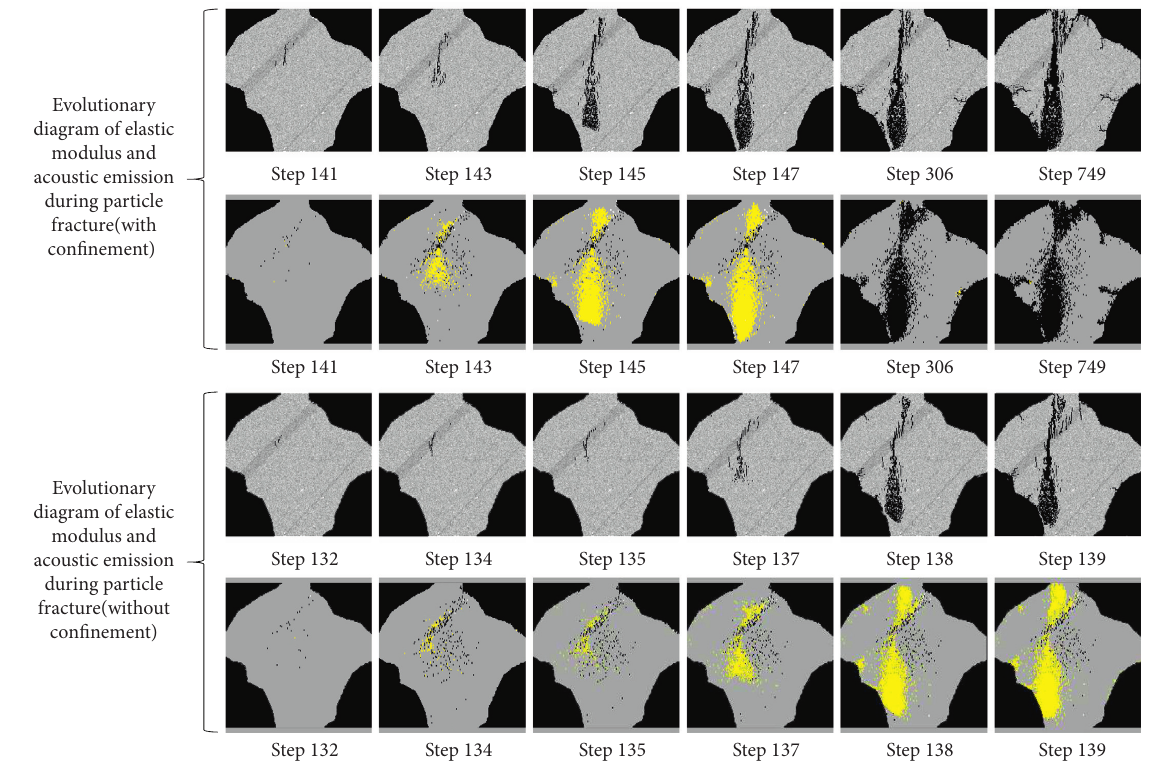
Figure 10: Evolutionary diagram of acoustic emission and elastic modulus of irregular particles during